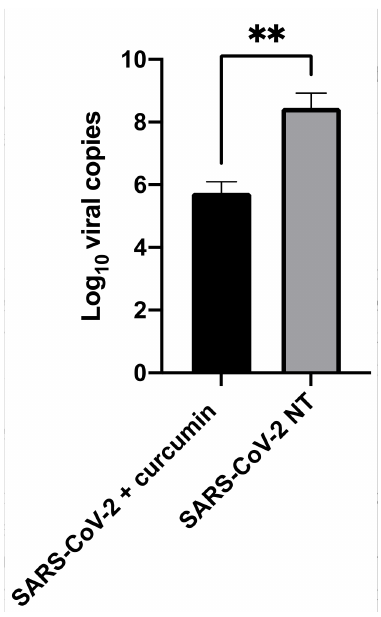
Figure 3. The effect of curcumin (10 µ M) on virion integrity, tested by means of the RNAse protection assay. Non-treated (designed as SARS-CoV-2 NT) and treated viruses (designed as SARS-CoV-2 + curcumin) are displayed. The viral load is expressed as Log 10 viral copies. Results from Mann– Whitney tests are shown. ** p -value <